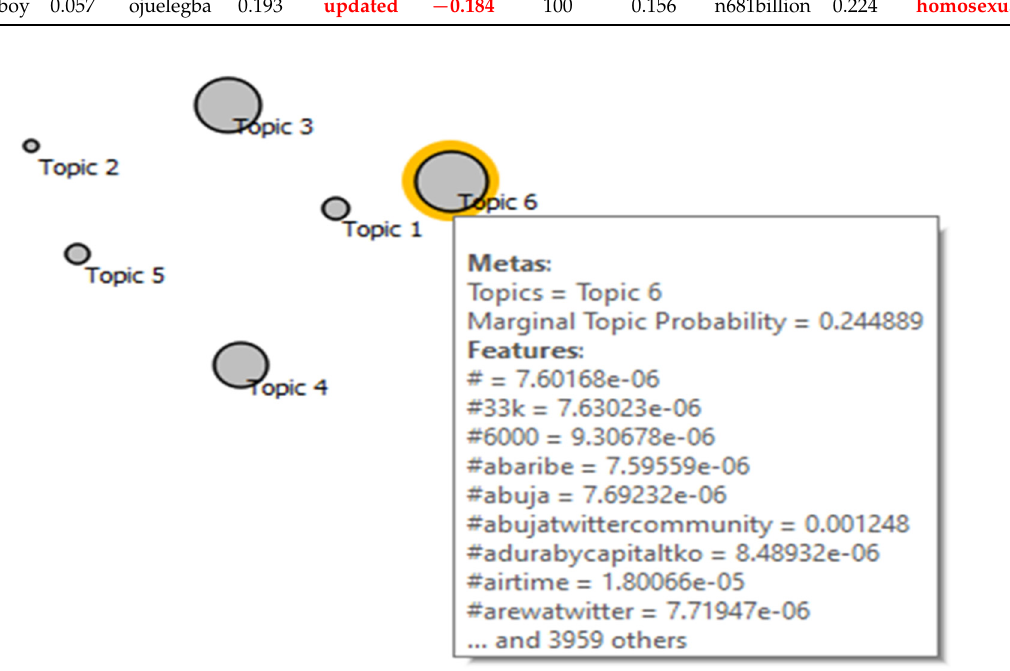
Figure 9. The cloud of words that constitutes LDA and LSI generated topics 1, 2, 3, 4, 5 and 6. The topics represent the point in the Multidimensional Scaling (MDS) graph, where the size of the point is a function of the Marginal Topic Probability (MTP) for each topic extracted from the tweet corpus. The bigger the size of the point, the stronger the topic is represented by the words in the corpus. Only the LDA topics are visualized using MDS because LDA is easier to interpret than LSI even though it is more computationally inten- sive. The visualization of the LDA topics with MDS shows that topic 6 has the highest marginal probability of 0.244889, followed by topic 3 and topic 4. Figure 10 shows the LDA topics using MTP with multidimensional scaling points.